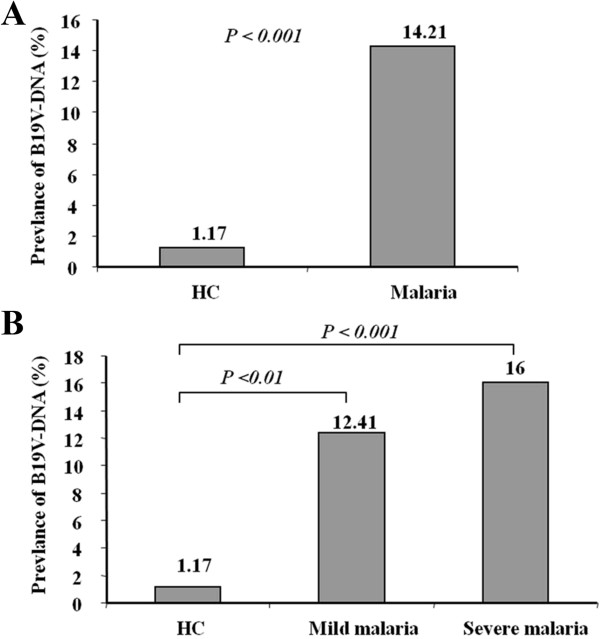
Prevalence of B19V genomes in children with P. falciparum and healthy controls. (A) Prevalence of B19V-genome detection in Gabonese patients with P. falciparum malaria and healthy control group (HC) (odds ratio (OR) = 12.08 (CI95 [1.62-90.28], two tailed Fisher’s exact test, P<0.001). (B) Distribution of B19V genomes in Gabonese patients with P. falciparum malaria according to their clinical presentation of malaria (mild and severe) and in healthy control group (HC) (OR =10.52 (CI95 [1.34 - 82.6] and OR=13.6 (CI95 [1.77 - 104.7], respectively, two tailed Fisher’s exact test, P<0.01).